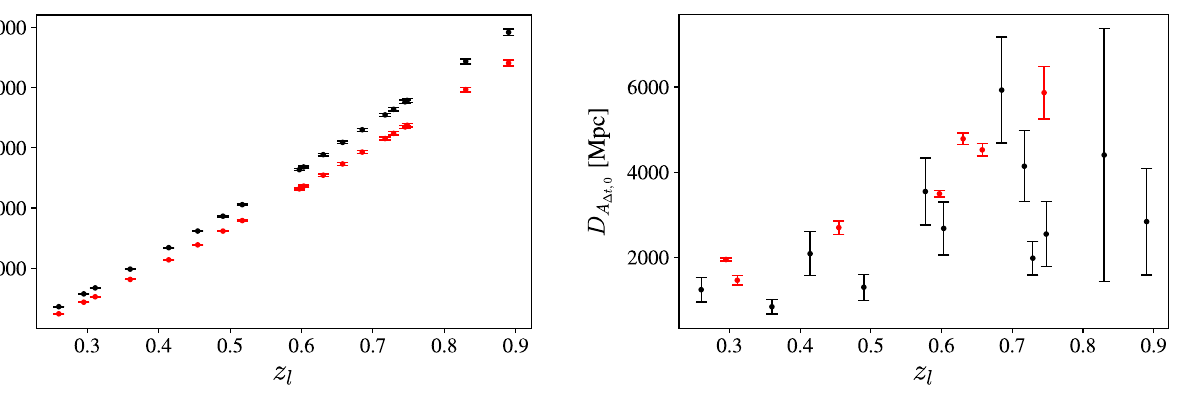
Fig. 1 The red points correspond to the D L data obtained by GP con- sidering M b R19, compatible with H 0 from the Ref. [62].The black points correspond to the D L data obtained by GP considering M b P18, compatible with H 0 from the Ref. [63]